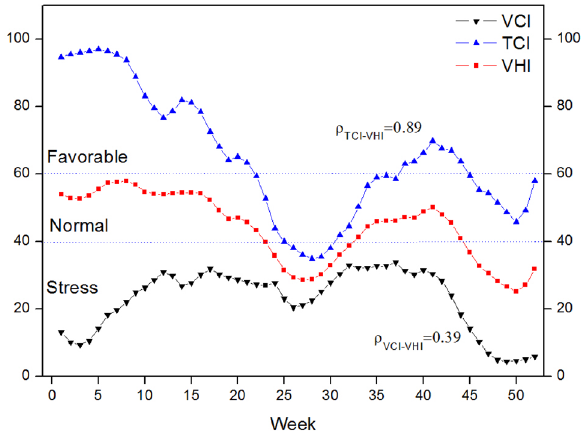
Figure 6. Dynamic change of regional average values of VHIs and their relationships in 2000 in Jing-Jing-Ji